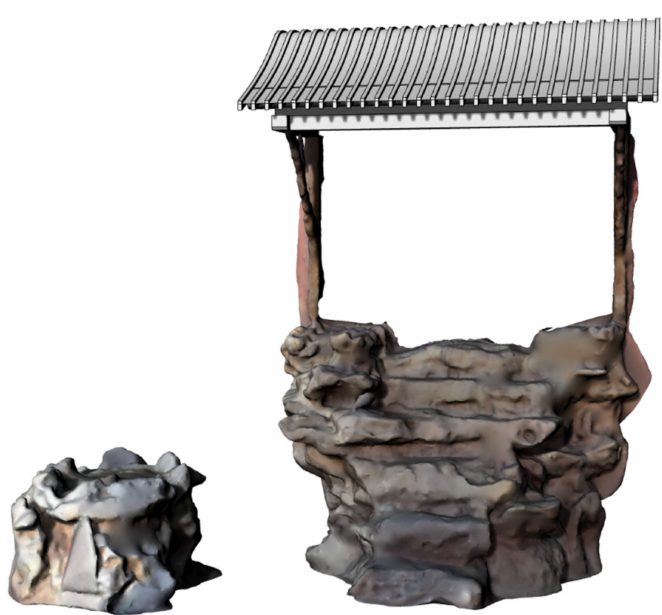
Figure 25. Irregular or “artistic” components created from photogrammetry or point